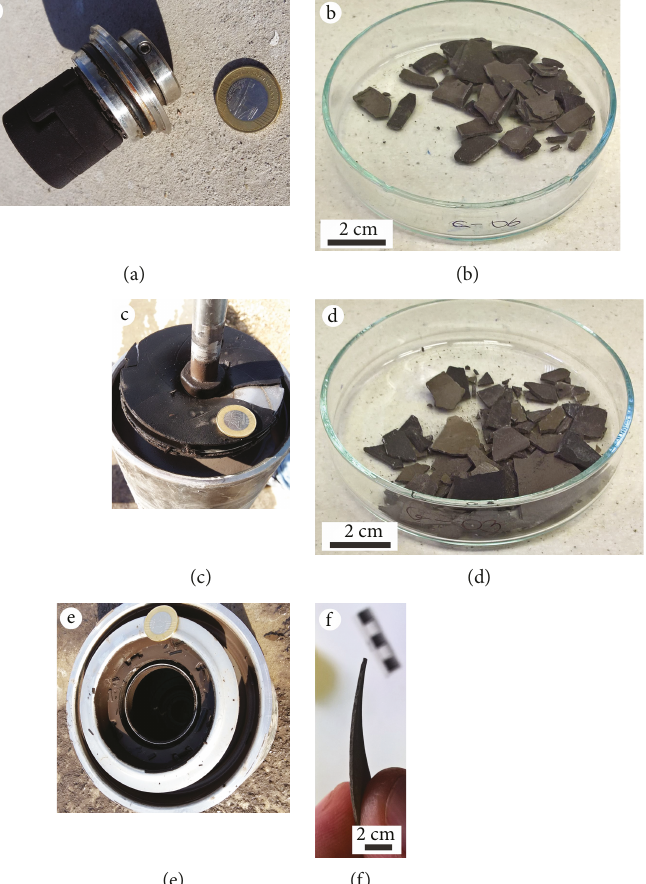
Figure 10: Scales from the Újszeged geothermal cascade system sampled in the engine room (interior surfaces of pumps). (a, b) Pump gland (sample G-06). (c, d) The last blade of the pump (sample G-08). (e, f) The fi rst blade of the pump (sample G-09). Note: a coin (diameter: 28.3mm) is shown to provide